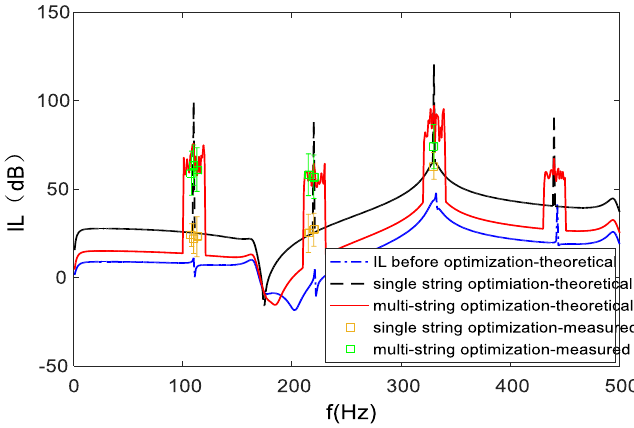
Figure 11. Comparison of the theoretical and experimental results.